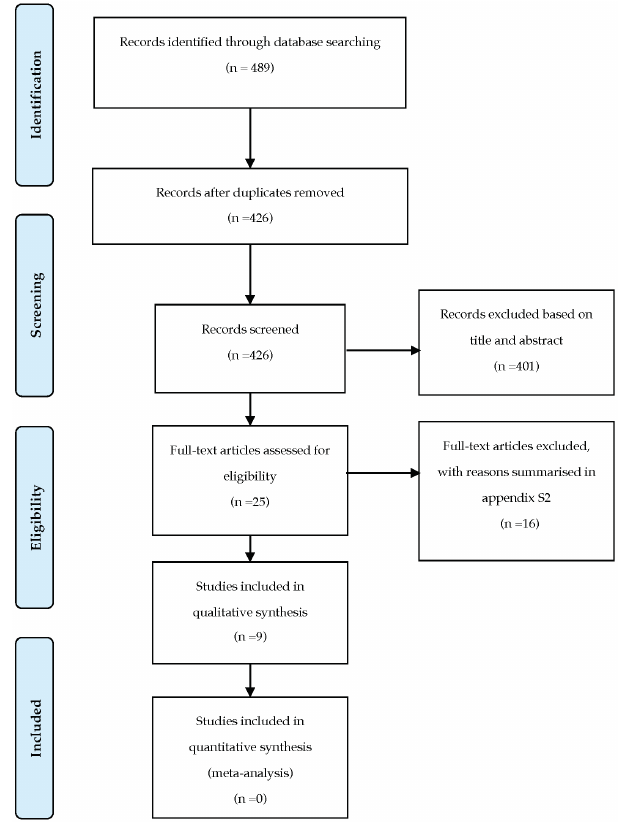
Figure 1. PRISMA flow chart.